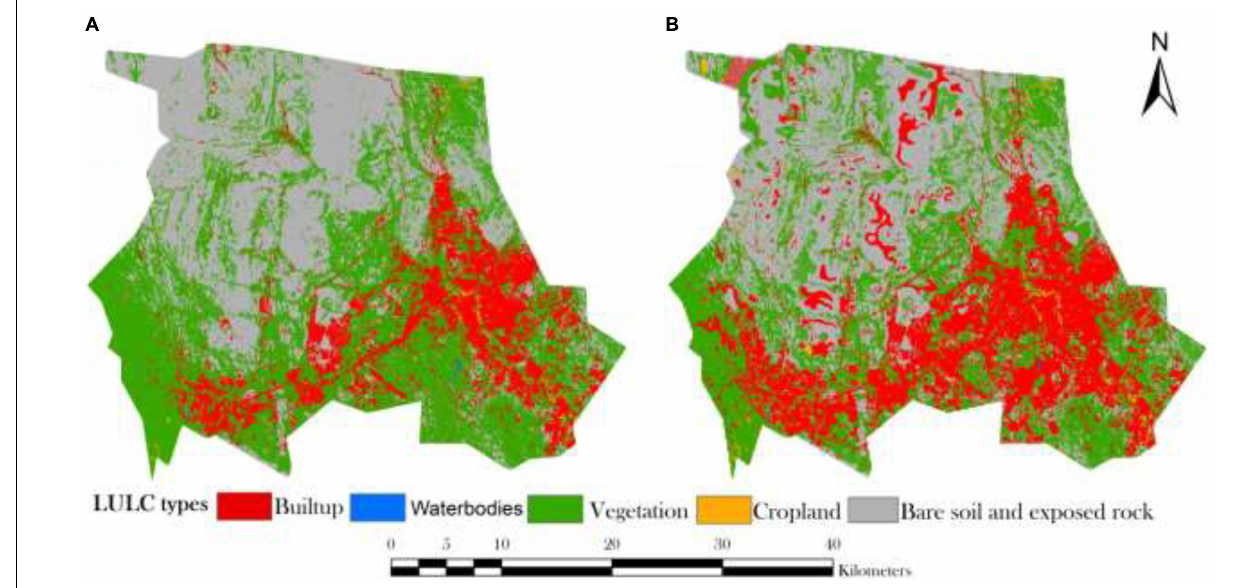
FIGURE 8 | The prediction of LULC using ANN-CA model for (A) simulating 2020, and (B) forecasting 2040 LULC.